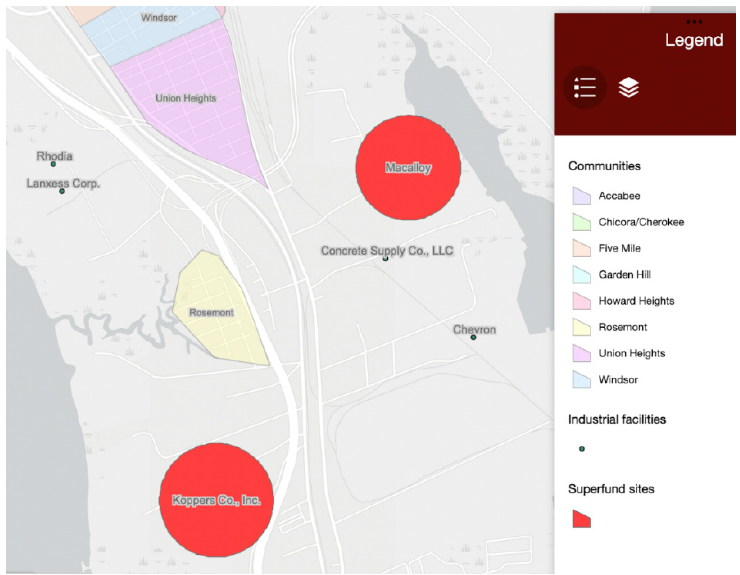
Figure 14. Locations of Superfund sites (large red circles) and industrial facilities (smaller black dots) that have experienced releases in the Charleston Neck